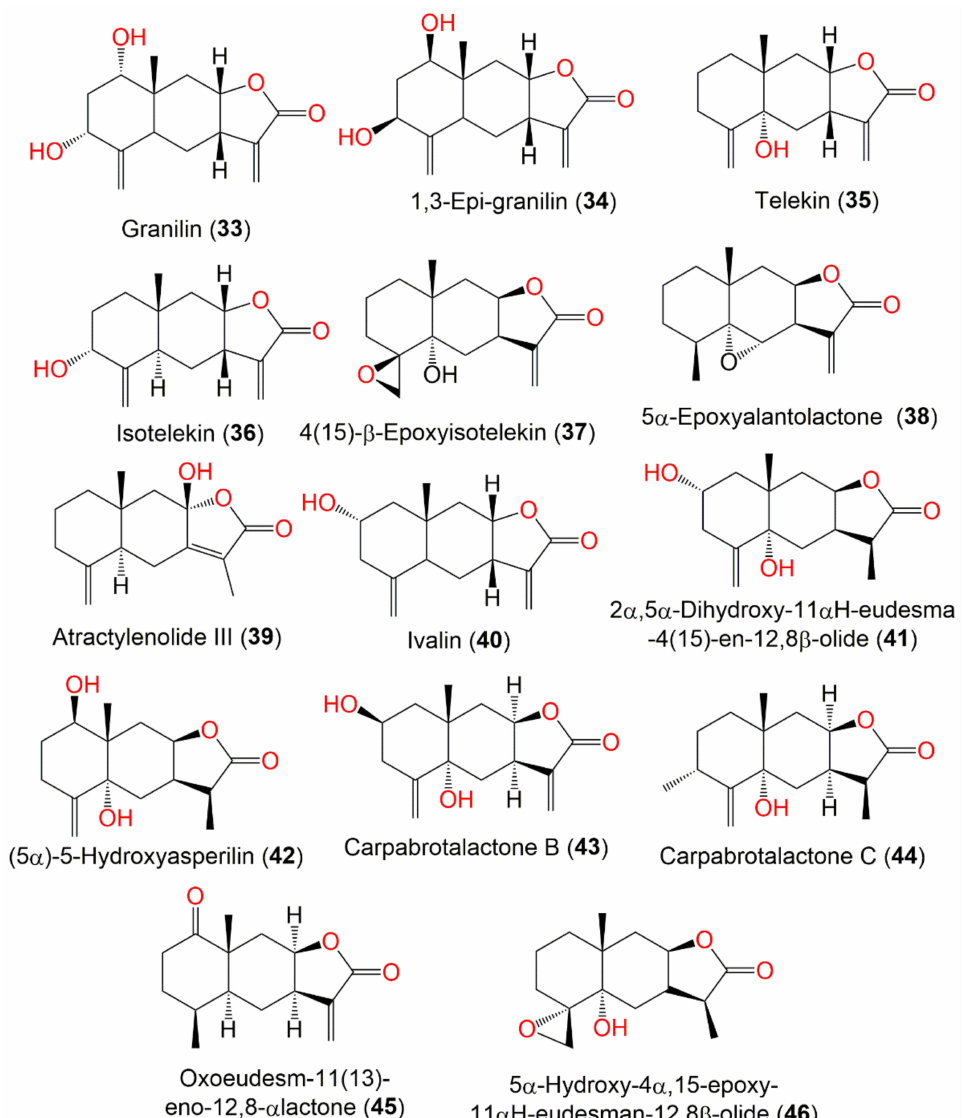
Figure 7. Eudesmanolide sesquiterpenes ( 33 – 46 ) reported from C. abrotanoides . In 2019, Wang et al. reported the separation of new eremophilane sesquiterpenoids, carperemophilanes A ( 53 ) and B ( 54 ), along with 56 from the EtOAc fraction of the whole plant 95% EtOH extract [60]. Compounds 53 and 54 had 1R/4S/5R/7S/10R configuration. These metabolites displayed cytotoxic capacities (IC 50 ranging from 7.45 to 37.35 µ M) versus MDA-MB-231 and HGC-27 in the MTT method, whereas 56 displayed potent effectiveness (IC 50 s 7.45 and 10.27 µ M, respectively). Biosynthetically, 53 and 54 are assumed to be produced from farnesylpyrophosphate (FPP) through the mevalonate pathway. Caroeremophilane A ( 53 ) is generated from FPP by annulation and a series of oxidation; however, a rare rearrangement and turning of the isopropyl group into n-propyl result in the formation of caroeremophilane B ( 54 ) (Scheme 3)